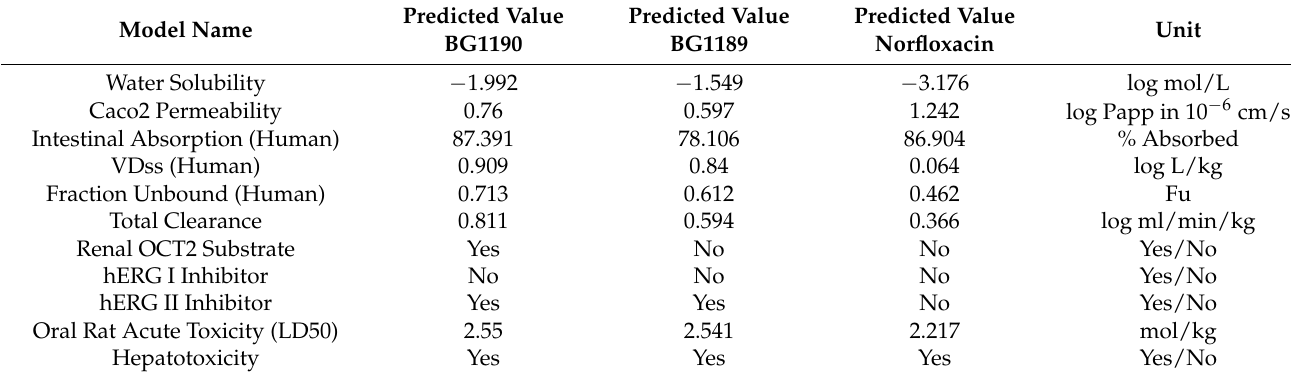
Table 2. Predicted ADMET results for BG1189 and BG1190 quinazoline derivatives compared with predicted ADMET values of